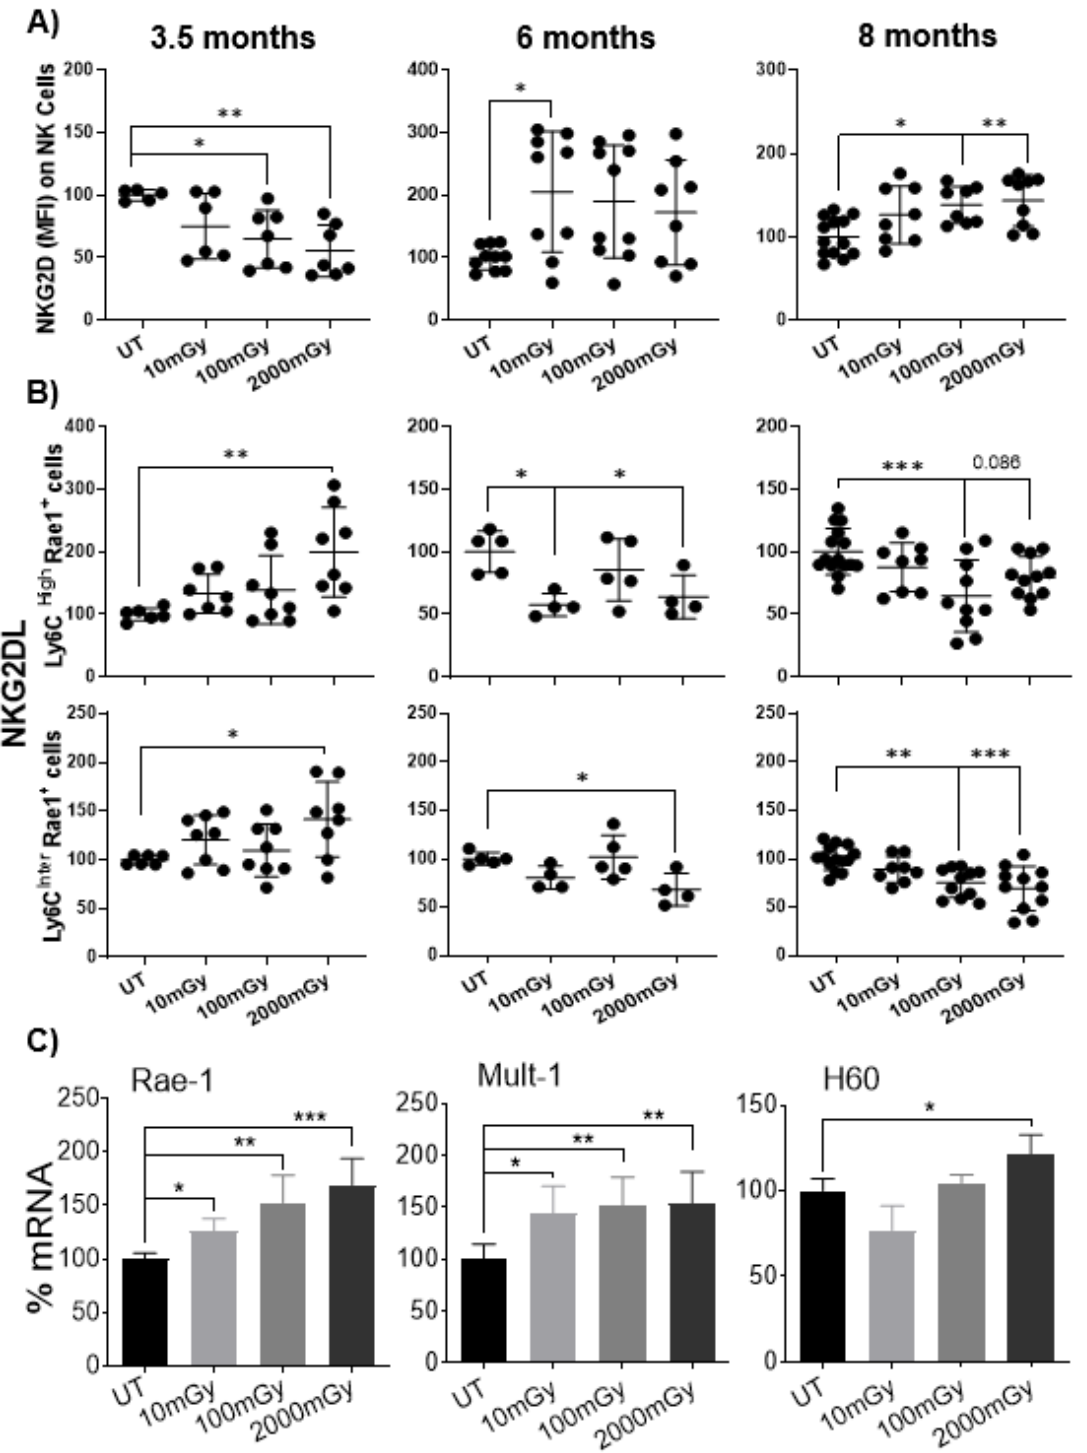
Figure 7. LDR modulates a cross-talk between NKG2D and its ligands. Isolated splenic cells from untreated and irradiated mice were stained with NKG2D or one of its ligands, Pan-Rae-1, prior to flow cytometry analysis. ( A ) Expression of NKG2D (MFI) on NK cells and ( B ) proportion of Ly6C+ cells expressing Pan-Rae1, a family of NKG2D ligands (NKG2D-L), on splenic leukocytes were measured. Y-axis in ( A ) represents the relative MFI of NKG2D staining and ( B ) relative percent of Ly6C+ cells expressing NKG2D-L. MFI and percent cells in untreated mice were set to 100%. ( C ) mRNA expression levels of NKG2DL (Rae-1, Mult-1 and H60) in spleens of mice from 3.5-month time point. Data represent mean + SD. * p < 0.05, ** p < 0.01, *** p < 0.001.